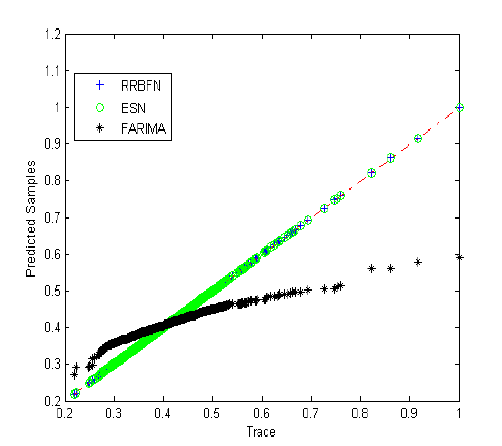
Fig. 10. 10-Step Q-Q Plot(1-Minute Interval)